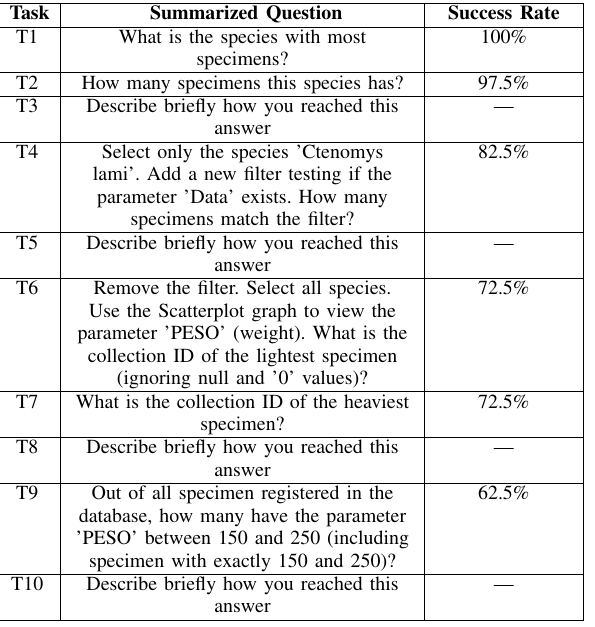
Table I S UCCESS RATE IN PERFORMING THE TASKS : RESULTS ARE THE PERCENTAGE OF CORRECT ANSWERS TO THE QUESTIONS POSED TO SUBJECTS THAT PARTICIPATED IN THE ASSESSMENT .